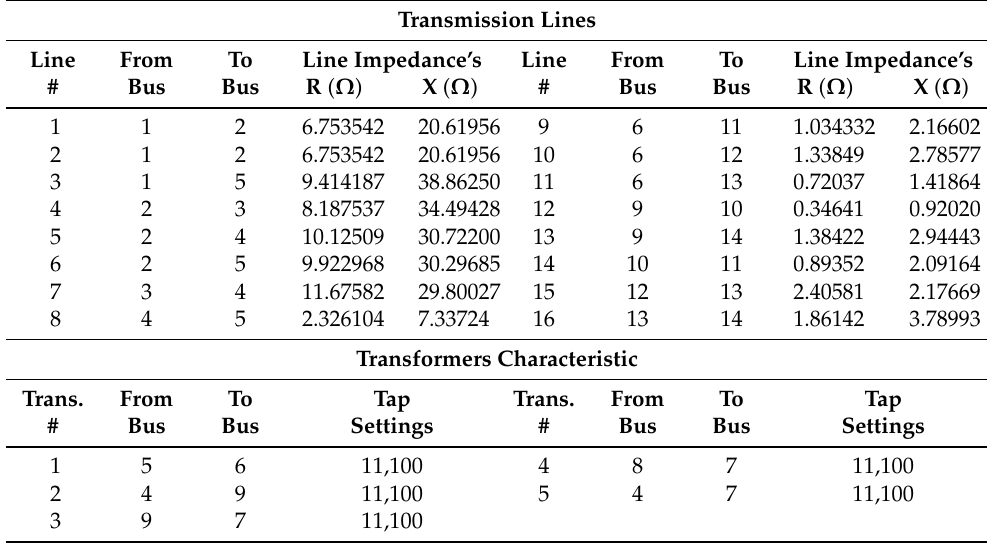
Table 4. Parameters for the IEEE 14-bus test